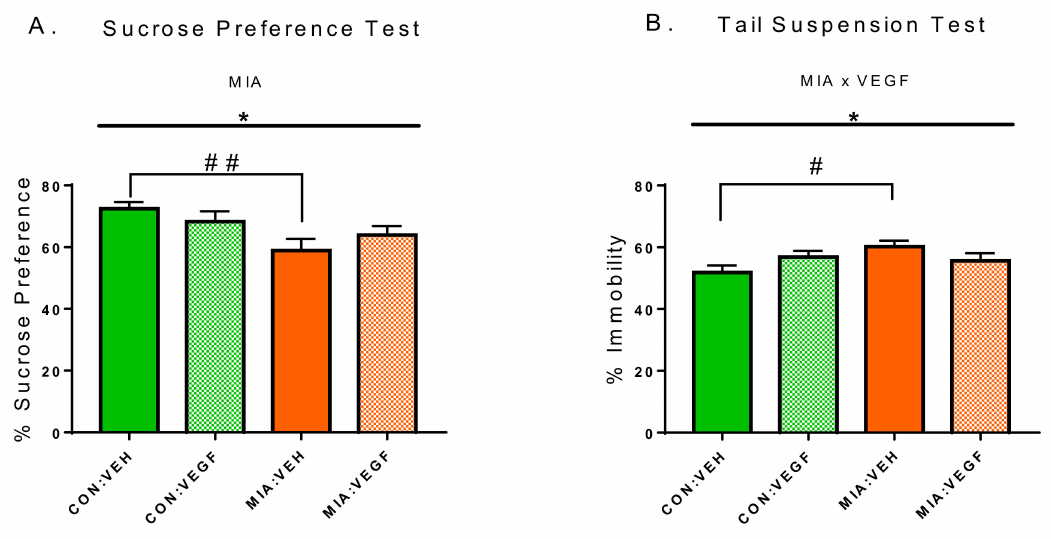
Figure 2. Behavioral e ff ects of VEGF infusion in control (CON) and MIA o ff spring. ( A ) Percentage of sucrosepreferenceinthesucrosepreferencetest(SPT).( B